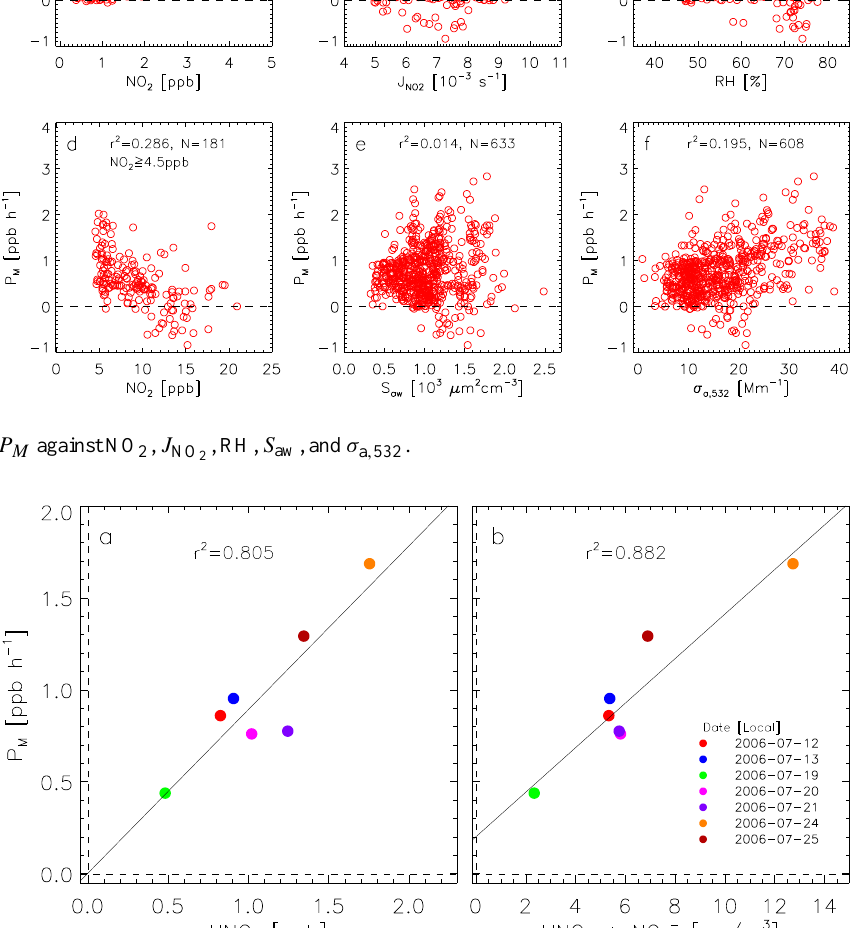
Fig. 10. Correlation of the average noontime (11:00–13:00LT) additional HONO production rate ( P M ) against the averaged HNO 3 concen- tration over the previous 24h period (a) and the sum of the averaged HNO 3 and aerosol nitrate (b) . The seven data points are color-coded for the different days of the campaign. The slopes of the regression lines represent a parameterization of the HONO formation rate, see text for